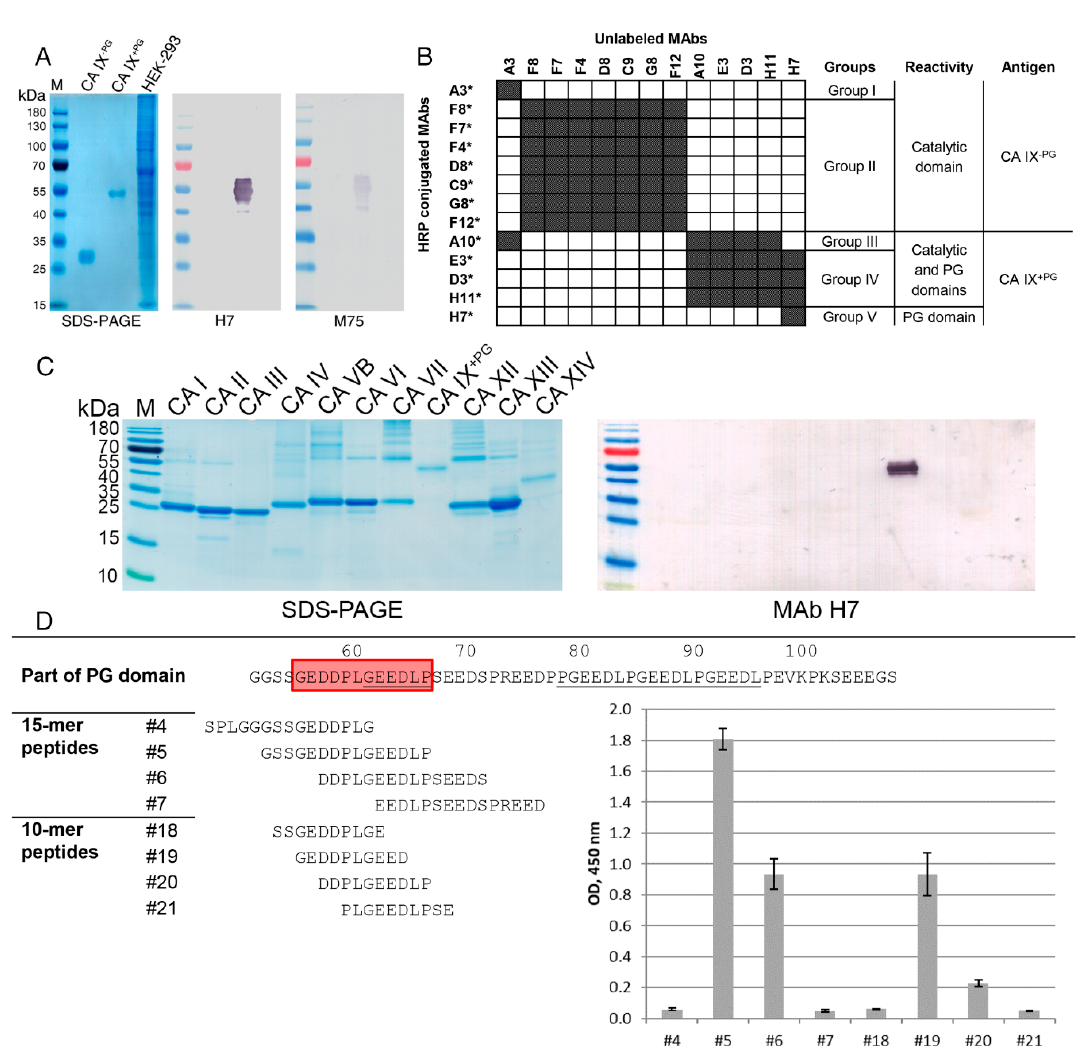
Figure 1. ( A ) The reactivity of MAbs H7 and MAb M75 with denaturized recombinant CA IX -PG and CA IX +PG proteins. Sodium dodecyl sulfate–polyacrylamide gel electrophoresis (SDS-PAGE) (the most and CA IX + PG proteins. Sodium dodecyl sulfate–polyacrylamide gel electrophoresis left) and immunoblots are shown. Line M, prestained MW marker; purified recombinant CA IX − PG and CA IX +PG were fractionized; lysate of HEK-293 cells was used as a negative control. ( B ) Summarized results of competitive ELISA and the proposed MAb classification into groups. White